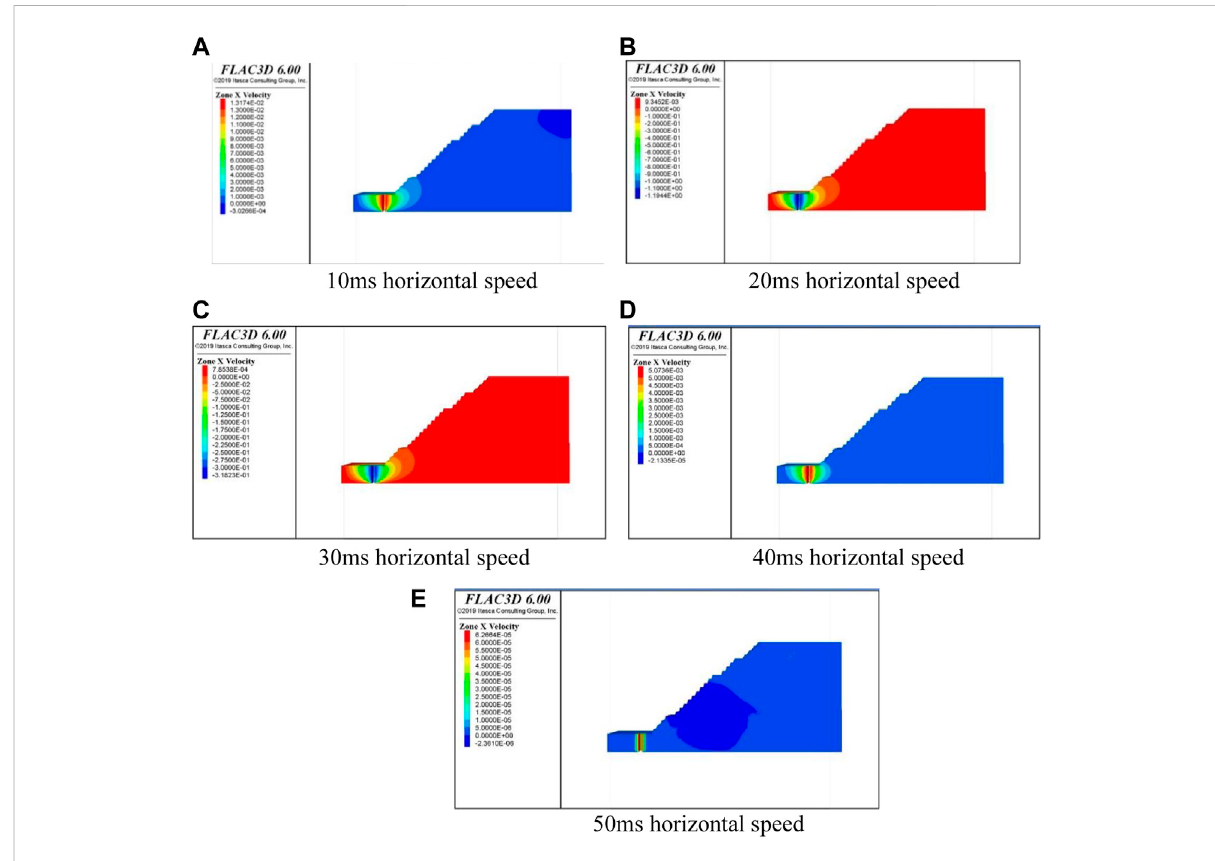
FIGURE 17 Horizontal displacement cloud